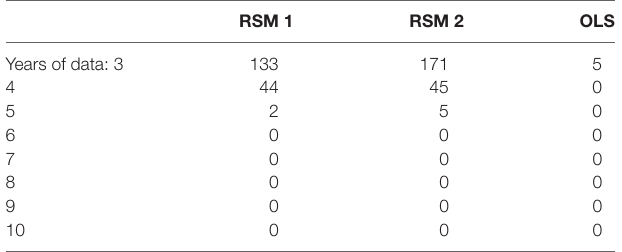
tABLe 2 | The number of correlations, out of 1,000, that were less than 0.0001 (including negative values) for between the estimated slope and the true underlying slope.